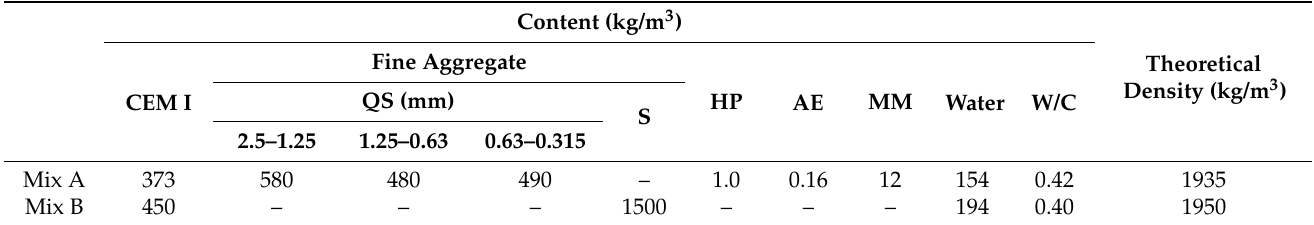
Table 5. Proportions of concrete mixes (mortars).